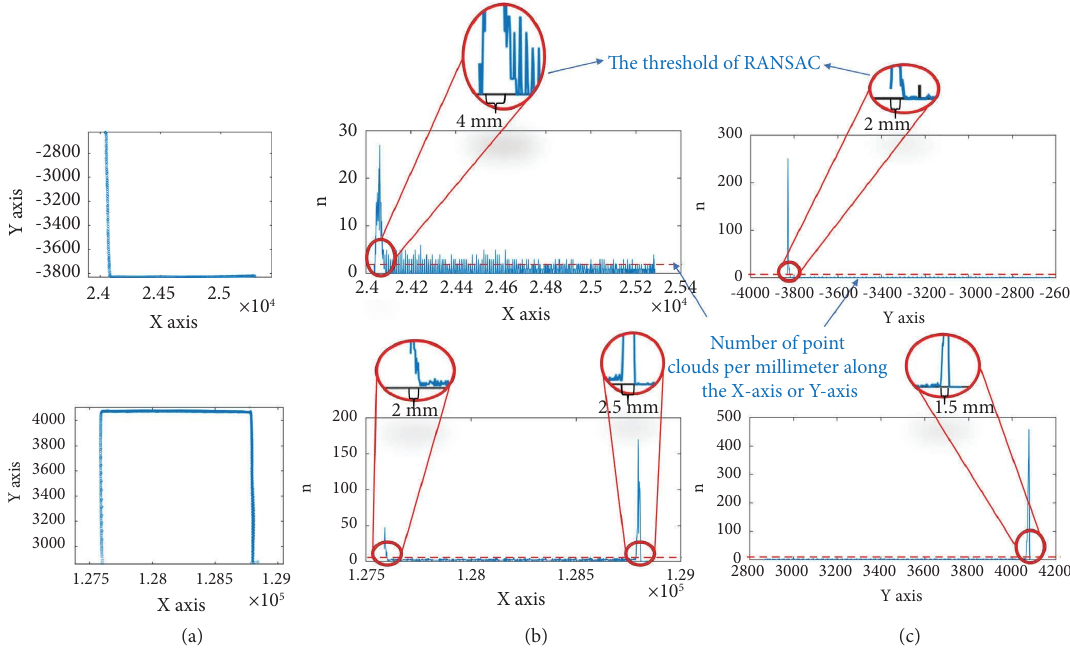
Figure 6: Calculation step of the threshold in RANSAC: (a) cross section of the point clouds, (b) number of point clouds per millimeter along X -axis, and (c) number of point clouds per millimeter along Y